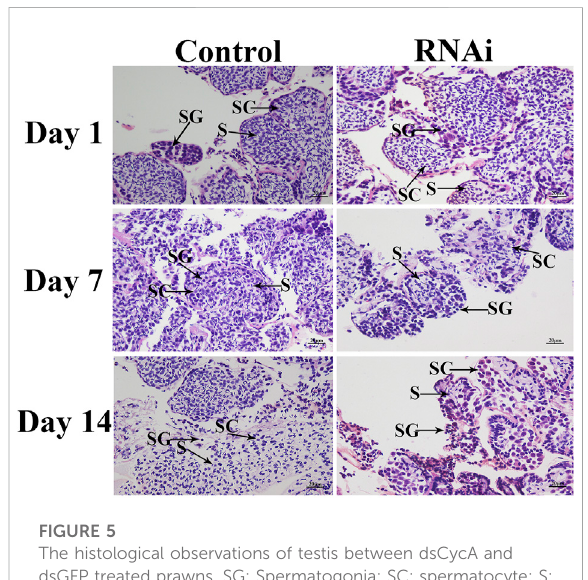
FIGURE 5 The histological observations of testis between dsCycA and dsGFP treated prawns. SG: Spermatogonia; SC: spermatocyte; S: sperm. Scale bars = 20 μ